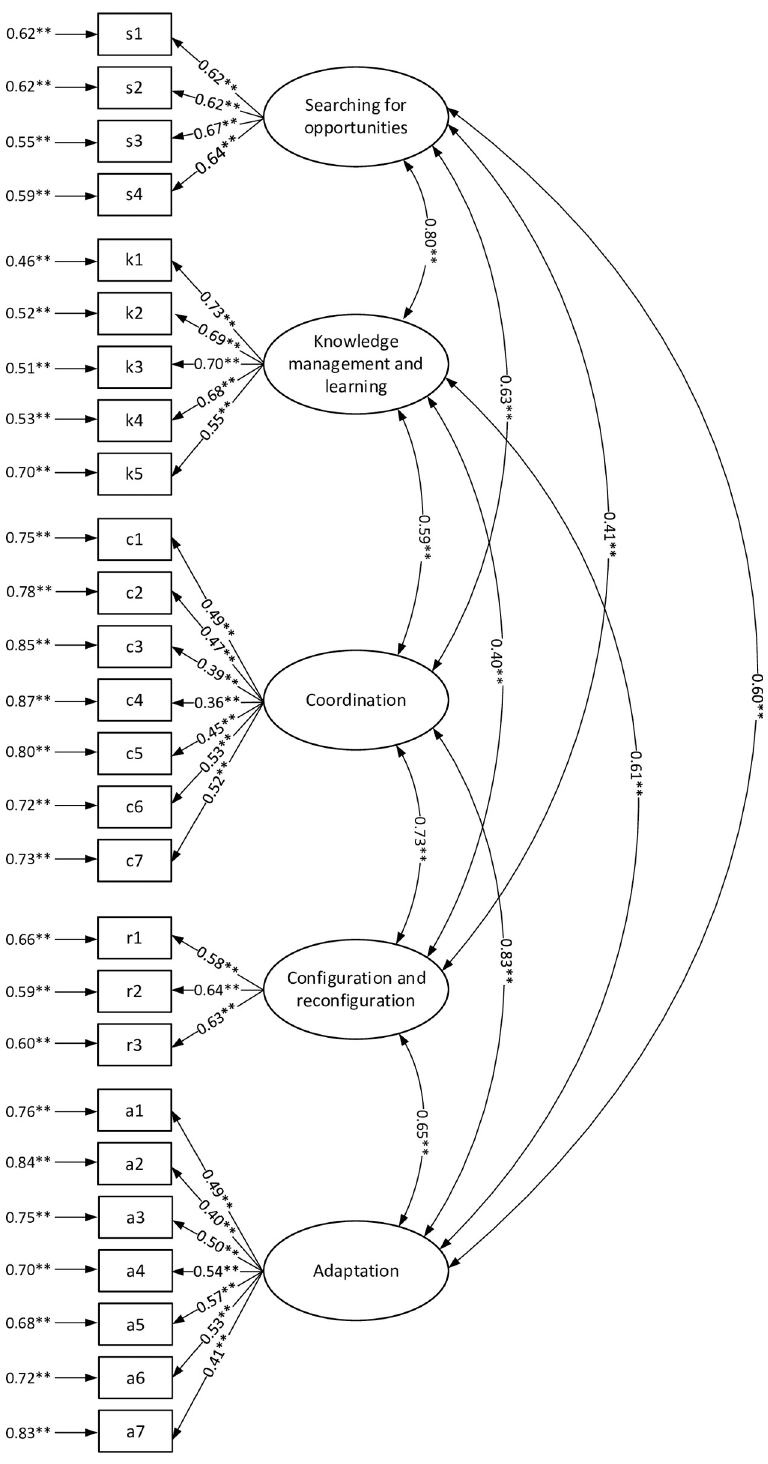
Fig 1. Confirmatory factor analysis for the measurement model of dynamic capabilities (factor loadings error variance and correlation coefficients). Source: Own study.